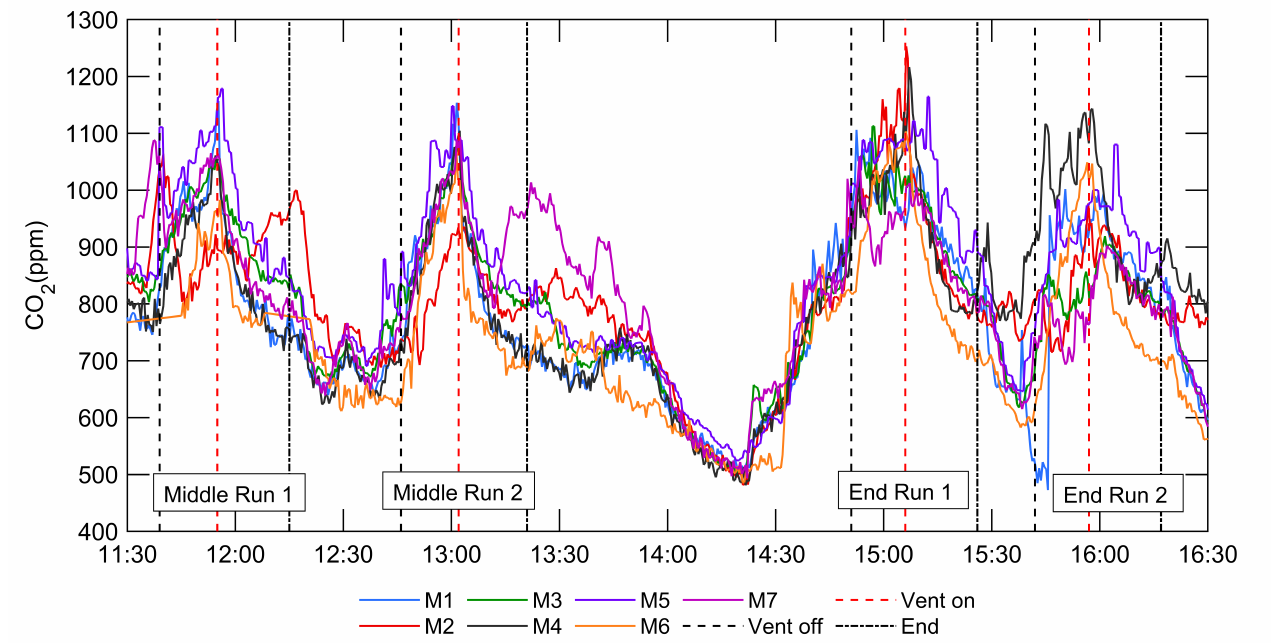
Figure 7. CO 2 measurements for all sensors between the start of the first experiment and the end of the last experiment. The first two experimental runs were conducted near the middle of the carriage, while the last two were conducted near the end of the carriage and an extract vent. Following “Middle Run 2”, the occupancy of the carriage reduced to zero, resulting in a large drop in CO 2 . Passengers returned to the carriage shortly before 14:30, resulting in an increase in CO 2